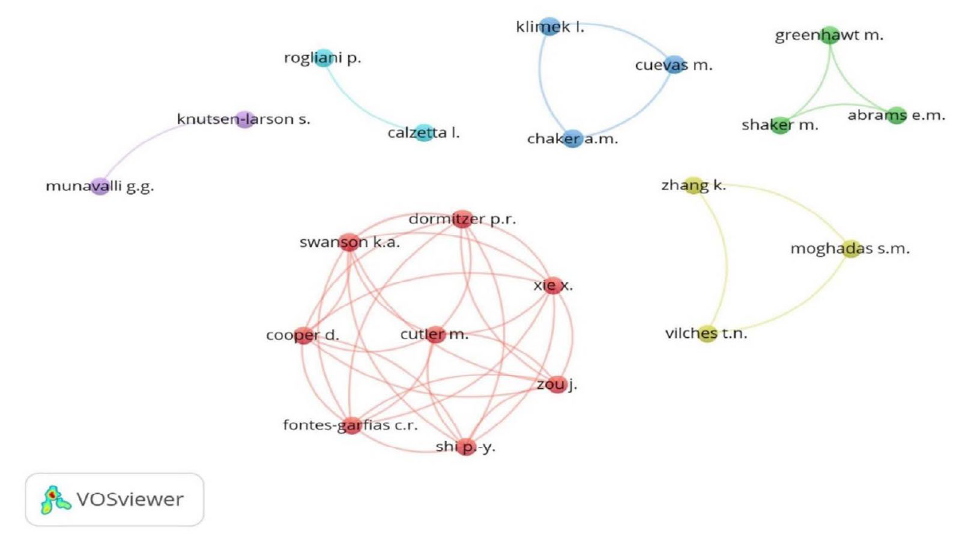
Fig. 2. The co-authorship network for